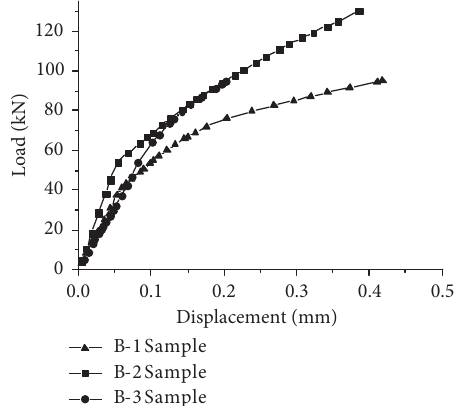
Figure 7: Simulated displacement load curve of three